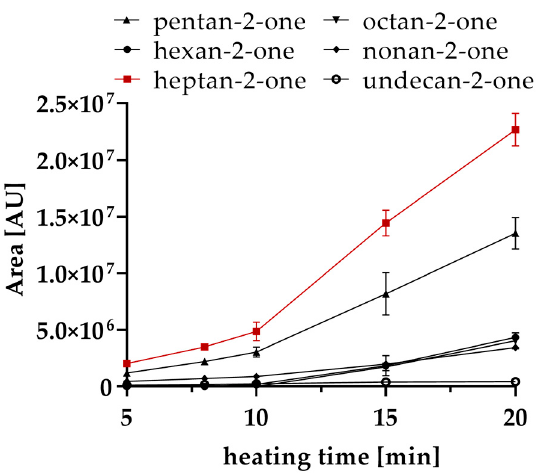
Figure 1. Peak area of six different methyl ketones in 1 g clarified butter heated at 160 °C for 20 min and analyzed by headspace gas chromatography mass spectrometry (HS-GC-MS). 2.2. Formation of Methyl Ketones from Linoleic Acid.